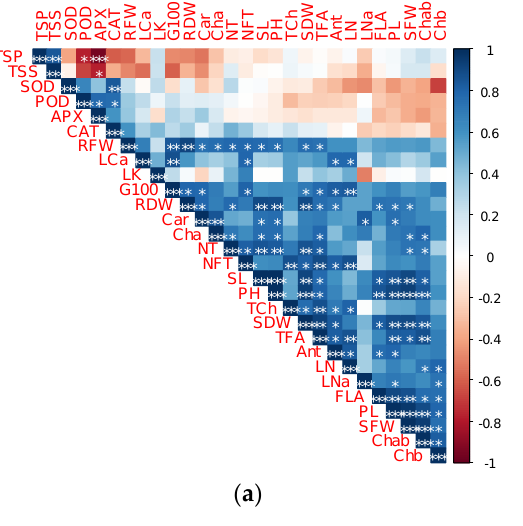
Figure 8. Pearson’s correlation matrixes constructed for growth, physiological and yield attributes of laser−primed ( a ) FSD−2008 and ( b ) Anaj−2017 wheat varieties under drought stress. For abbreviations of priming levels and plant attributes, please see the footnote of Figure 7. * significant at p≤0.05%; ** significant at p≤0.01%; *** significant at p≤0.001%.